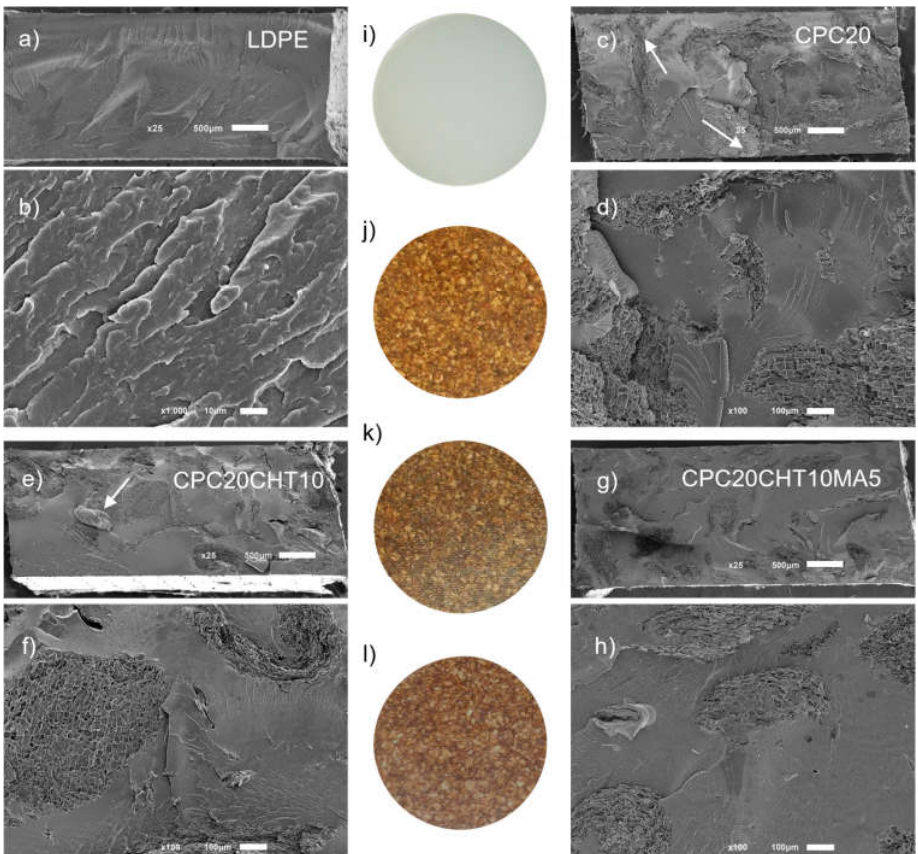
Figure 6. Cross-section morphology for the bio-based LDPE ( a , b ), CPC20 ( c , d ), CPC20CHT10 ( e , f ), and CPC20CHT10MA5 ( g , h ) and the visual aspect of the developed materials for the antimicrobial tests, with 35 mm of diameter and based on LDPE ( i ); CPC20 ( j ), CPC20CHT10 ( k ) and CPC20CHT10MA5 ( l ). ( a , c , e , g ) Magnification at ×25 (scale bar 500 µm) and ( b , d , f , h ) higher magnification of ×100 (scale bar 100 µm).